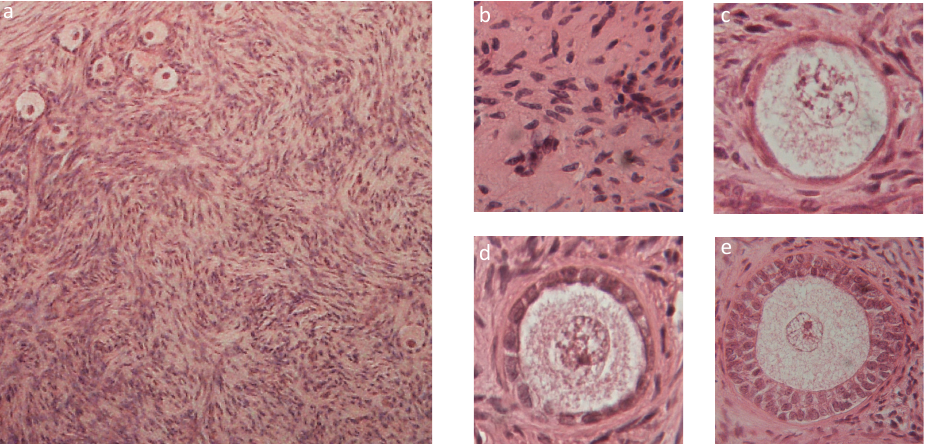
Figure 7. Exemplary histological section of cortical ovarian tissue showing its cellular components: ( a ) whole section; ( b ) stromal cells; ( c ) primordial follicle; ( d ) primary follicle; ( e ) secondary follicle.